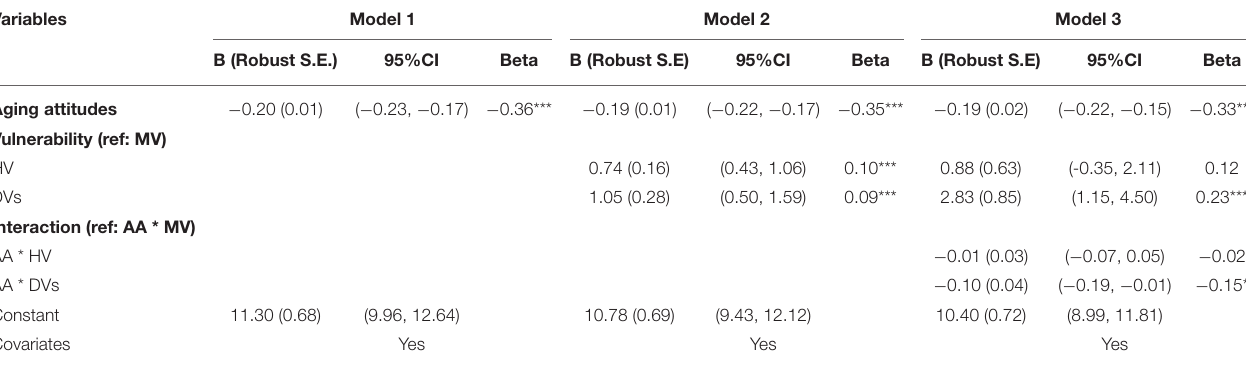
TABLE 5 | Weighted linear regressions of the relationship between aging attitudes, vulnerability type, and negative emotional responses among older adults ( N =